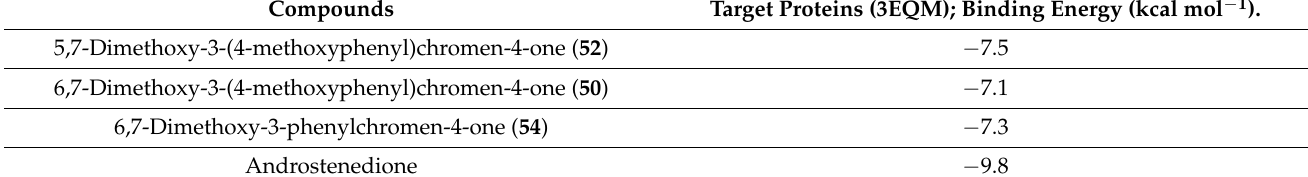
Table 2. Binding energy values of three isoflavone compound derivatives, 50, 52 and 54 , against aromatase